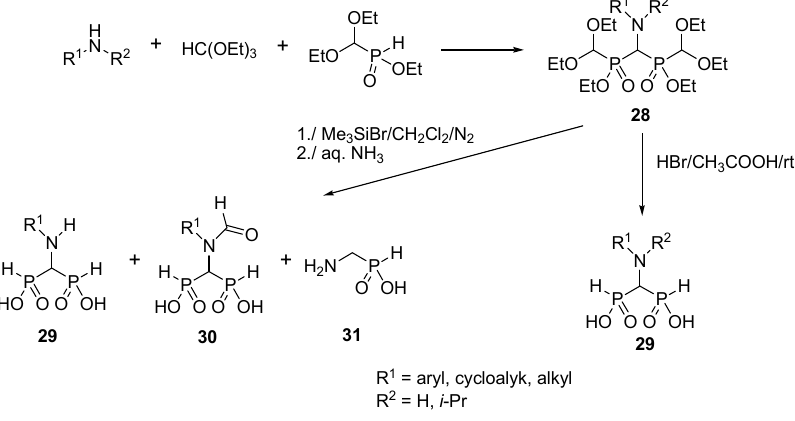
Scheme 17. Three-component synthesis of aminobisphosphonates.